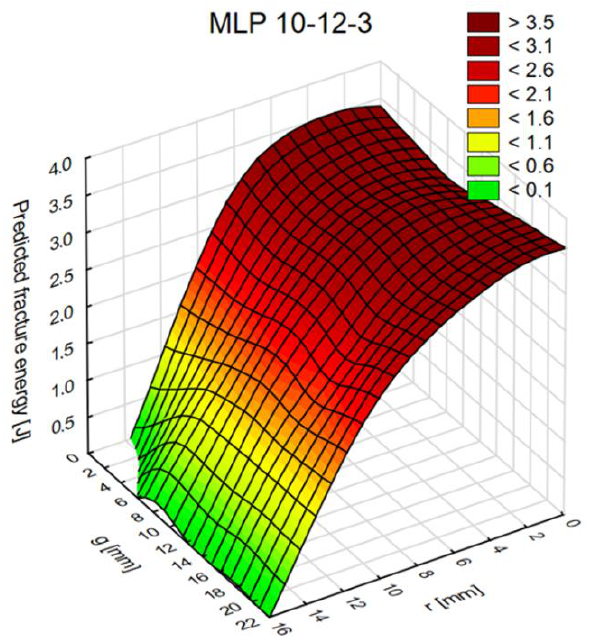
Figure 14. The graph of fracture energy values as a function of radius (r) and thickness (g).